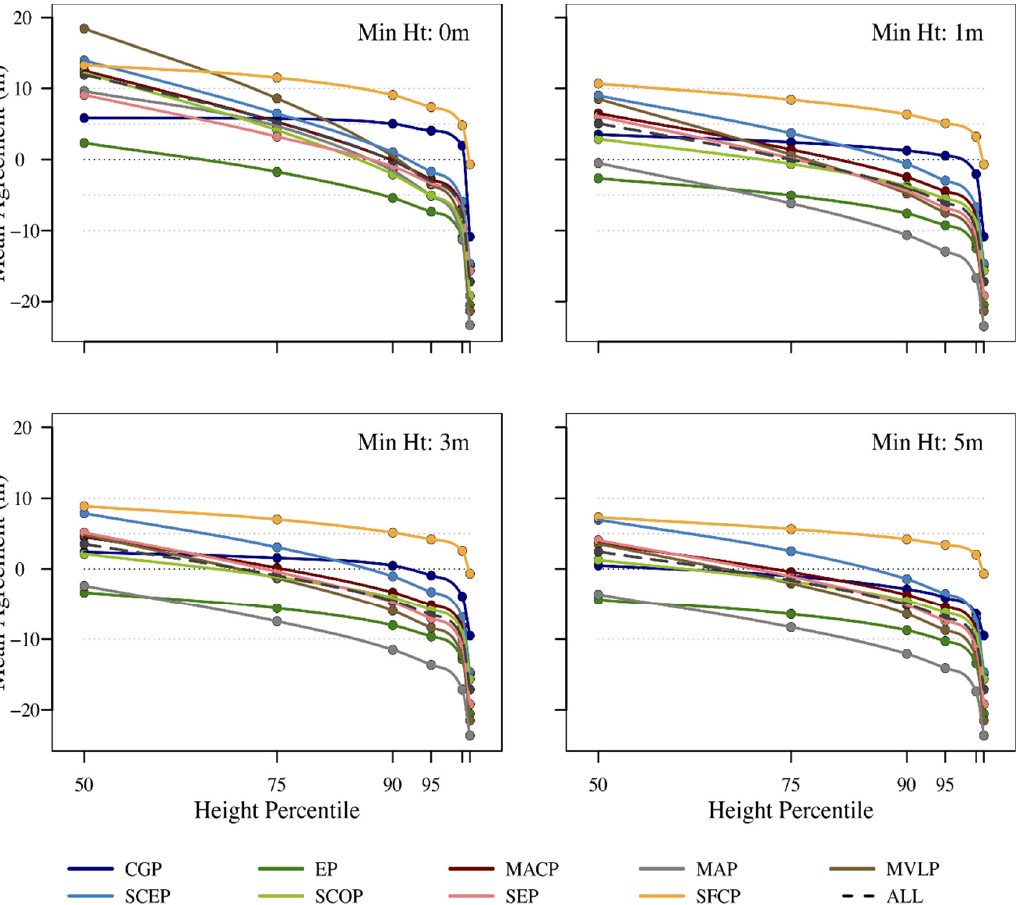
Figure 4. Mean agreement (MA) statistics by ecoregion (individual spline-fitted lines), height percentiles (horizontal axes), and minimum height categories (panels) computed during the assessment phase of the study. The spline-fits are strictly for visual display.